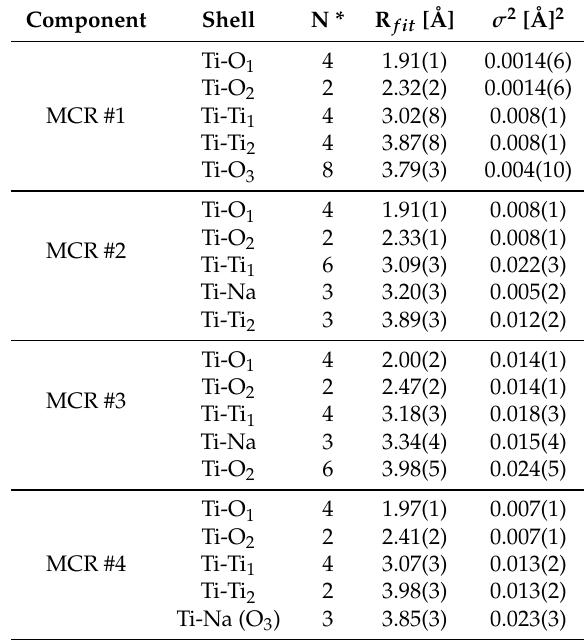
Table 1. Ti K-edge EXAFS fitting parameters of MCR-ALS components.